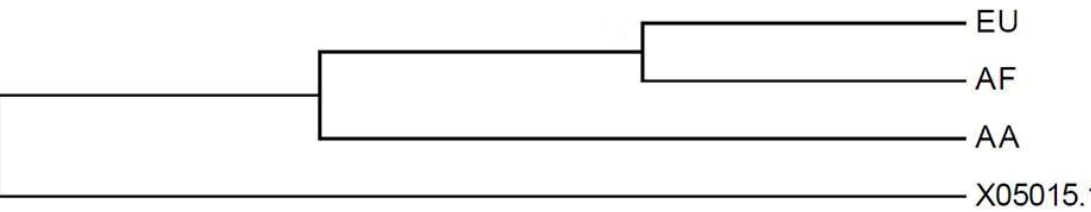
Figure 5. Phylogenetic tree comparing A-A, AF and EU variants similarity at the LCR